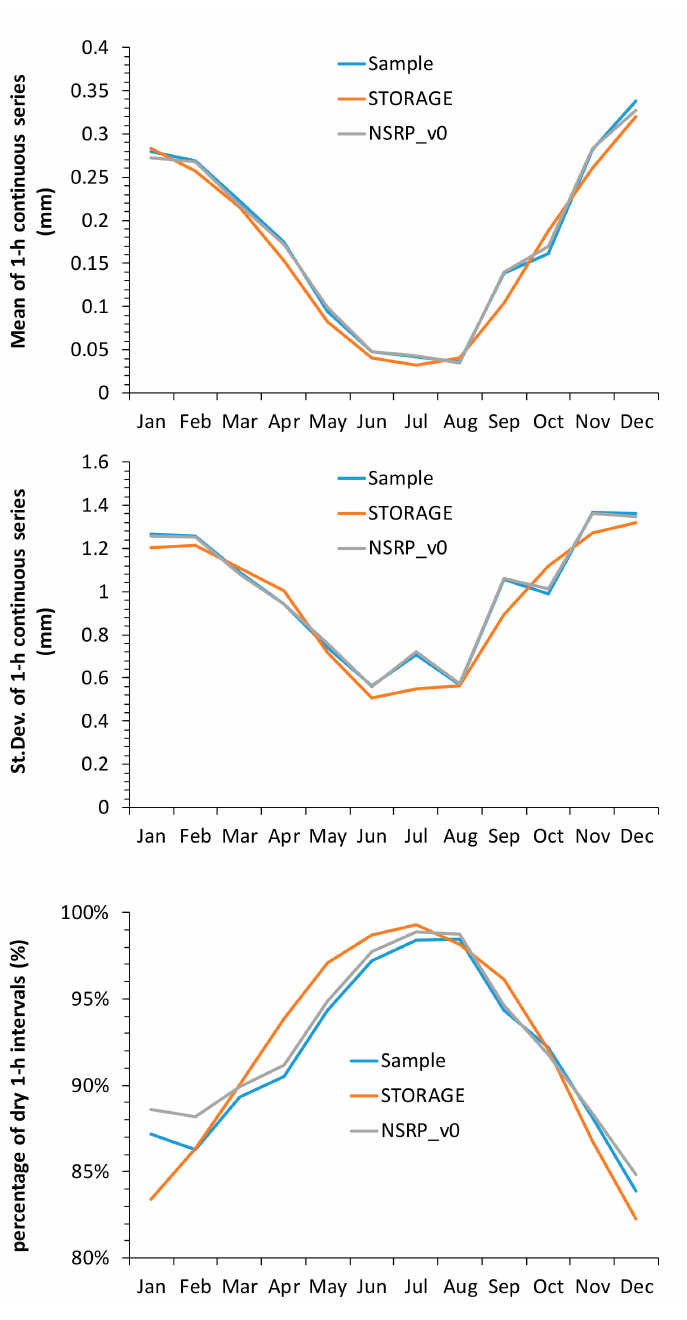
Figure 22. Montalto Uffugo rain gauge: comparison between STORAGE and NSRP_v0 performances, focusing on the mean, standard deviation and percentage of dry intervals for the continuous 1-h